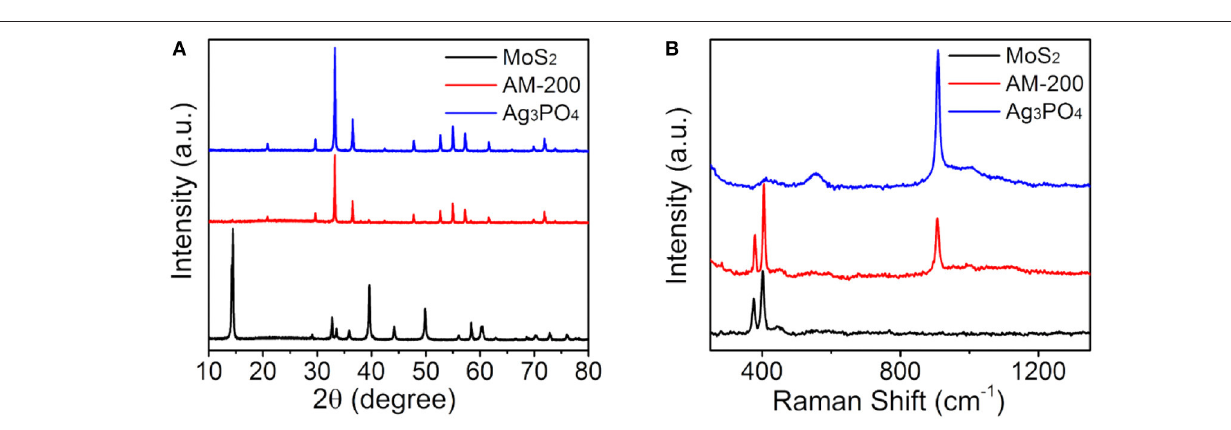
FIGURE 2 | XRD patterns (A) and Raman spectra (B) of pure Ag 3 PO 4 , MoS 2 , and the composite